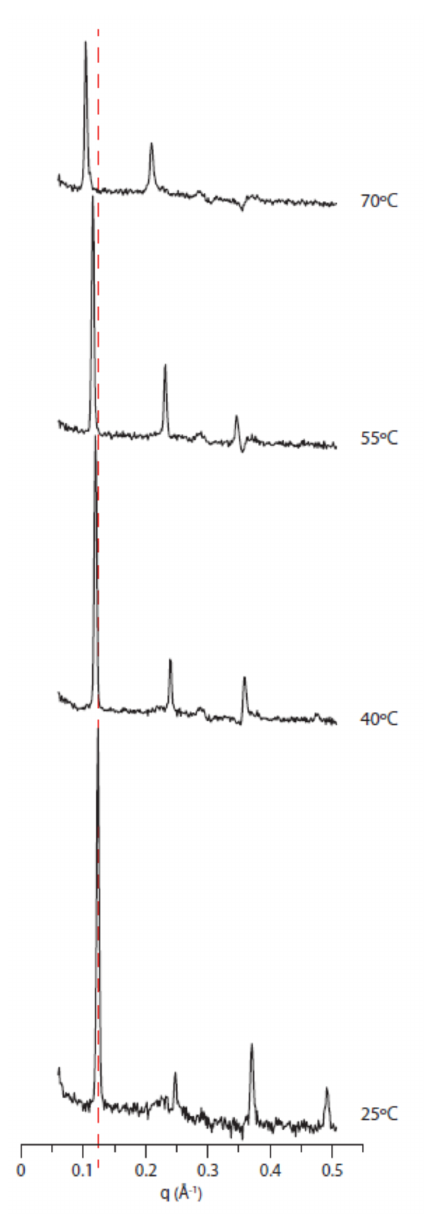
Figure 4. 1D neutron di ff ractogram as a function of temperature. Neutron di ff raction data DoPhPC:DoPhPE (9:1) after background subtraction obtained at 100% RH with 8% D 2 O as a function of temperature. The Y-axis intensity is (a.u.) at decimal log scale. The dotted line is guide for the eye to show the Bragg peak